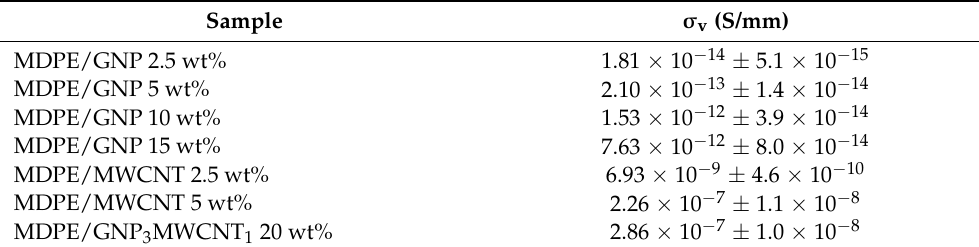
Table 1. Electrical conductivity of MDPE/GNP and MDPE/MWCNT samples at different filler concentrations, and MDPE/GNP 3 MWCNT 1 20 wt% nanocomposite.